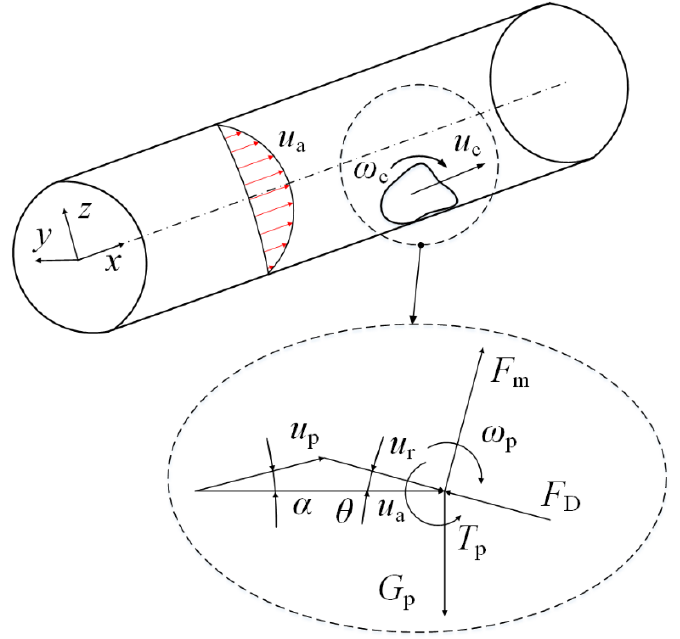
Figure 15. Forces analysis of single spraying particle in horizontal swirling pneumatic conveying.